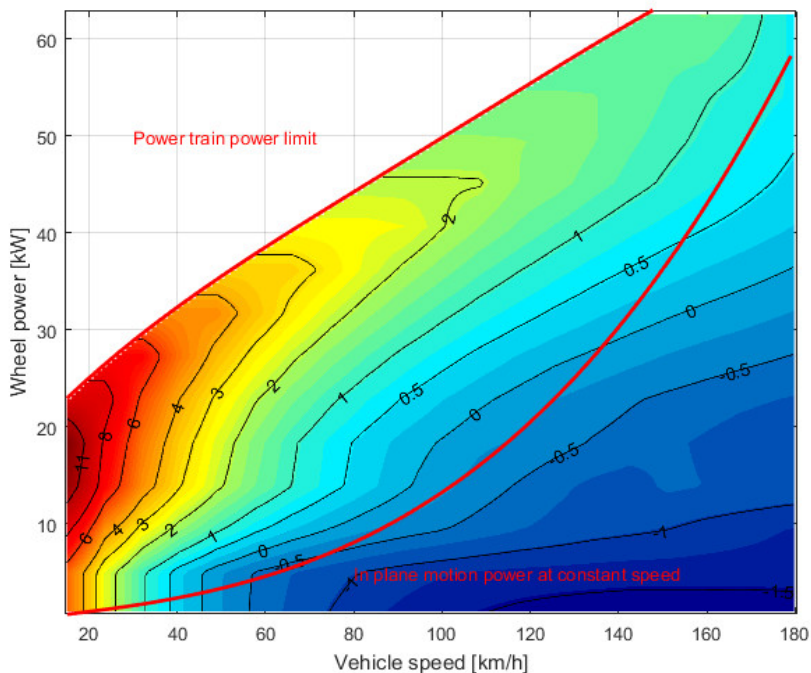
Figure 6. k steady-state function for each operating condition–CVT.